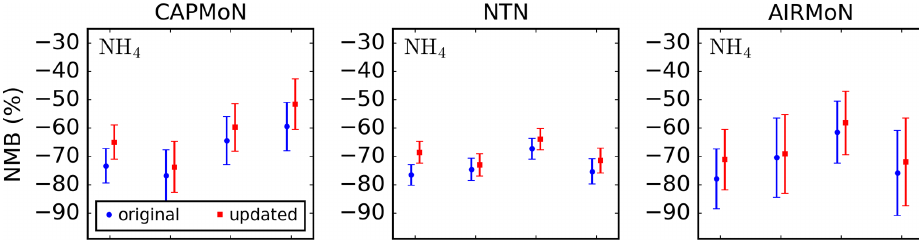
Figure 16. Normalized mean biases of GEM-MACH with original and updated ammonia emissions compared to ammonium precipitation observations from the CAPMoN, NTN, and AIRMoN networks. In the legend, “original” and “updated” indicate the ammonia emissions used in GEM-MACH. Error bars denote the standard